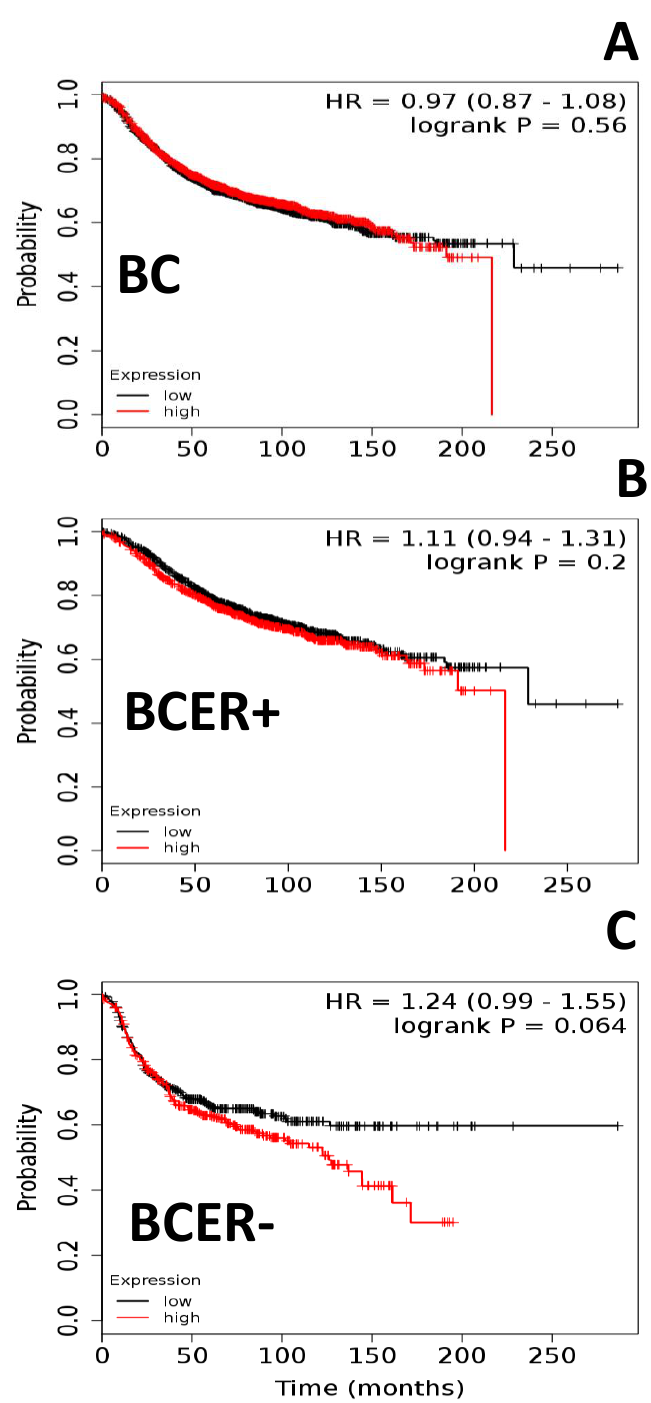
Figure 1. Leptin receptor (OBR) mRNA expression and survival of breast cancer (BC) patients. ( A ) Survival curves of patients (all breast cancer sub-types; n = 3951). ( B ) Survival curves of patients stratified by estrogen-receptor-positive BC (BCER + ; n = 2061) and ( C ) estrogen-receptor-negative BC (BCER − ; n = 801) subtypes. Kaplan–Meier survival plots were calculated for BC patients expressing low versus high levels of OBR mRNA according to data from the Cancer Genome Atlas (TCGA) [18–21]. Graphs depict relapse-free survival. Patients surviving beyond the timeline threshold (20 years and 10 months) were censored instead of excluded. Hazard ratio (HR) range and p -values (logrank P) were obtained for the BC subtypes using Kmplot.com software